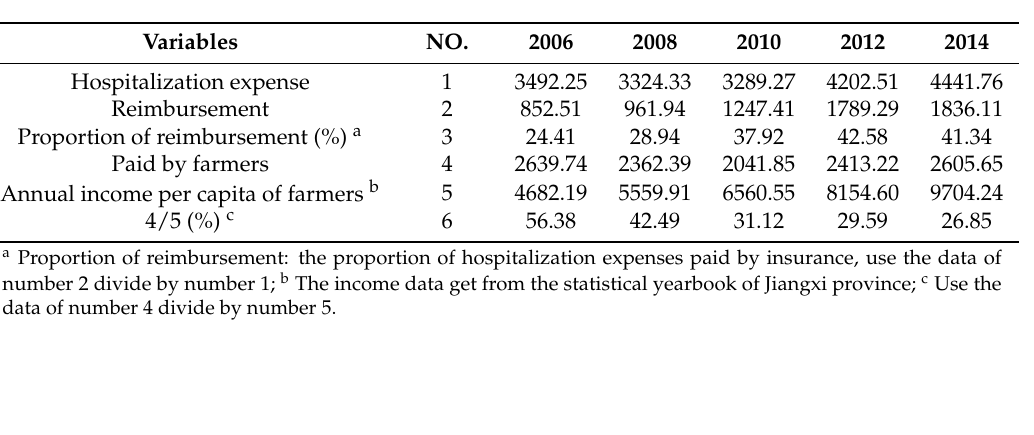
Table 3. Adjusted total hospitalization expense and the expense paid by farmers